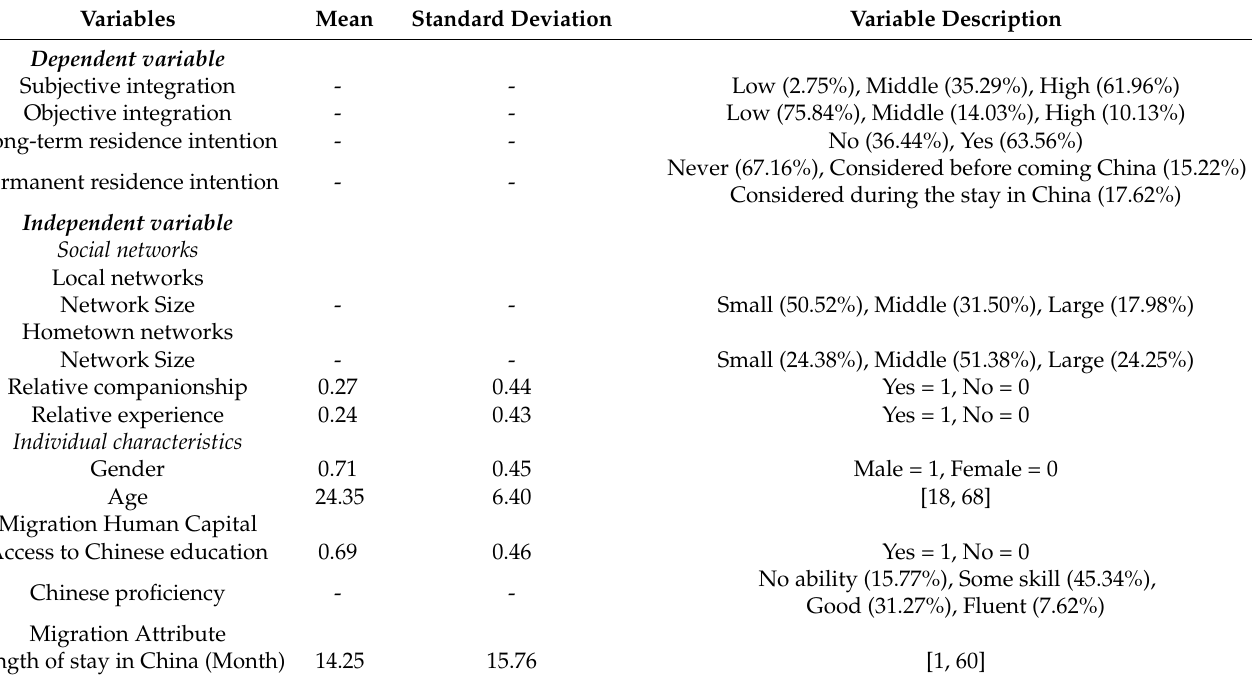
Table 1. Description Table of Variables ( n =